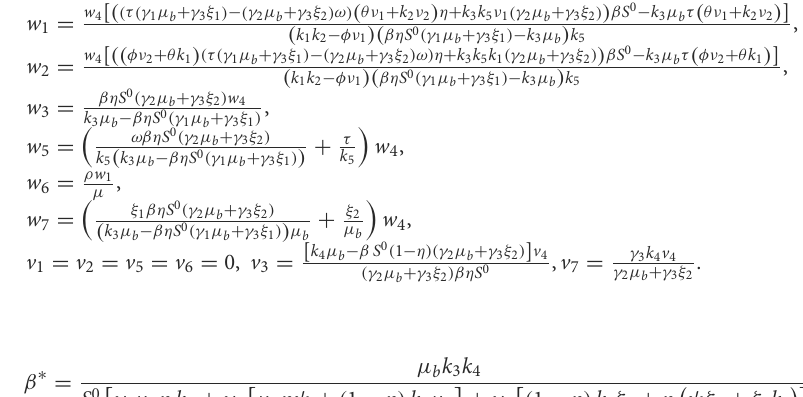
The left and right